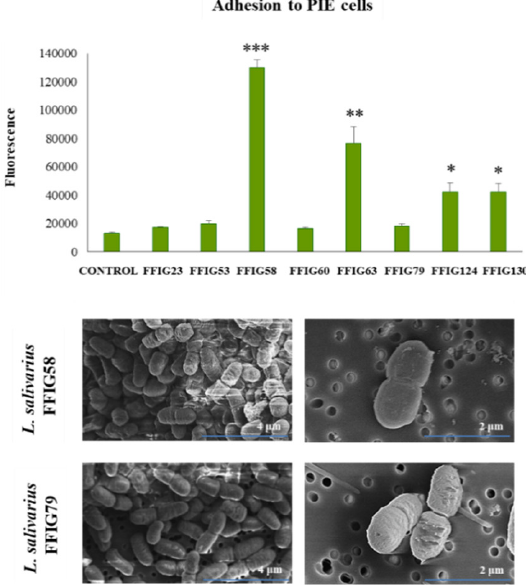
Figure 7. Adhesion of Ligilactobacillus salivarius strains isolated from the intestinal mucosa of wakame- fed pigs to porcine intestinal epithelial (PIE) cells. The results represent data from three independent experiments. Asterisks indicate significant di ff erences when compared to the control PIE cells (* p < 0.05, ** p < 0.01, *** p < 0.001). Scanning electron microscope (SEM) analysis of L. salivarius FFIG58 and L. salivarius